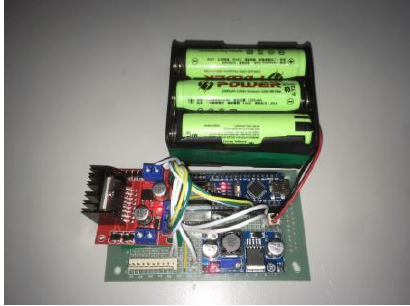
Figure 23. The circuit design of the system module.